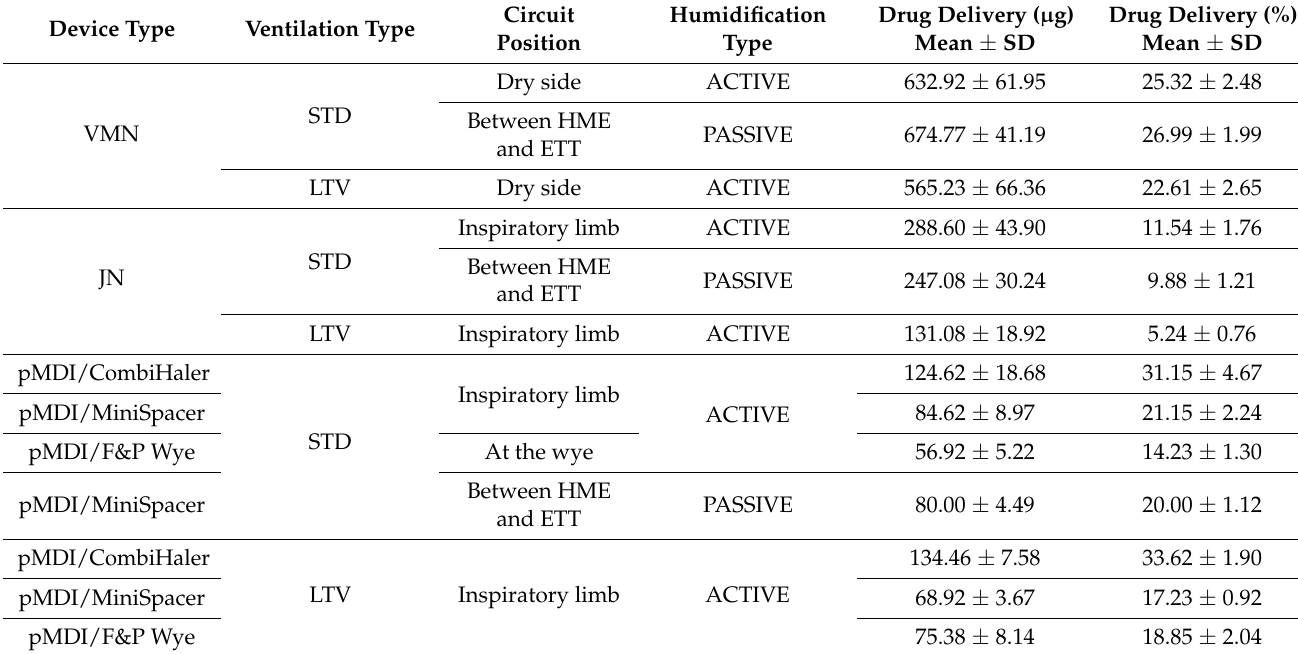
Table 2. Mean ± standard deviation drug delivered across three devices with differing ventilation strategies, humidification types and drug